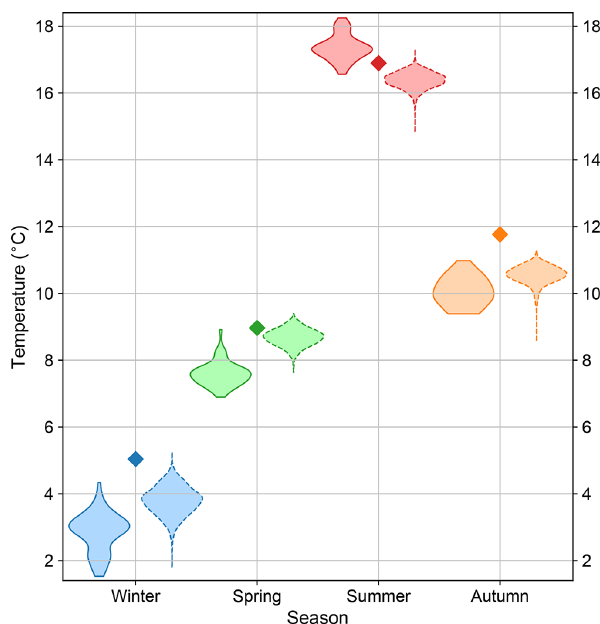
Figure 7. Distribution of mean temperatures in the Burgundian Low Countries from 1420 to 1499CE after data assimilation. Solid (dashed) violins show the seasonal distribution when 2m air tem- peratures from the 40-member (13-member) ModE-Sim ensemble (CESM-LME) are employed to generate the prior. Diamonds rep- resent recent seasonal mean temperatures obtained from regional observations within the CRUTEM5 dataset for the 2010–2021 time